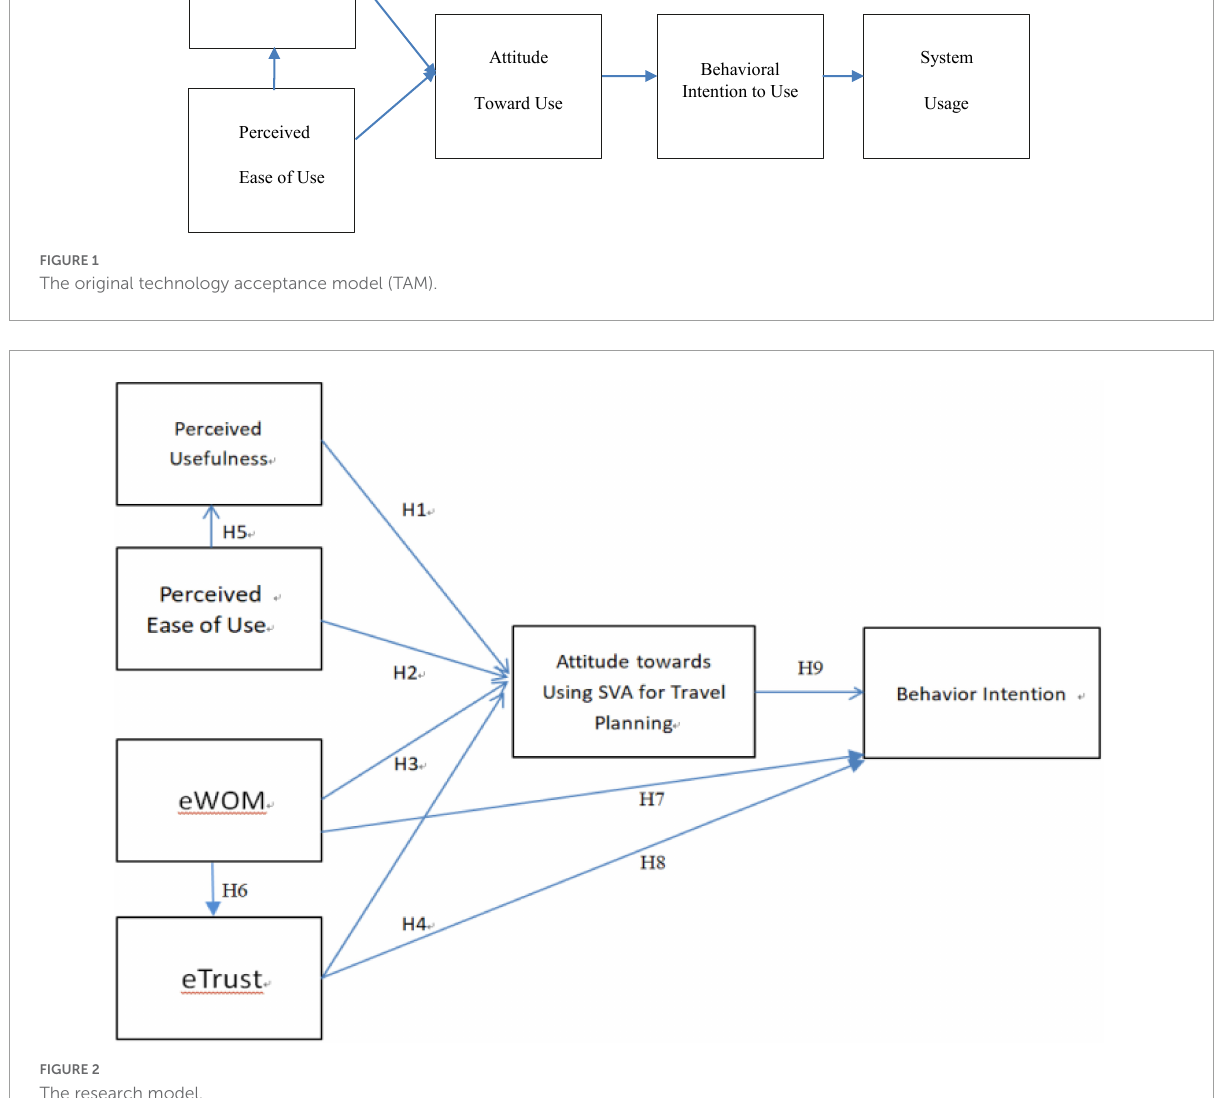
FIGURE2 The research